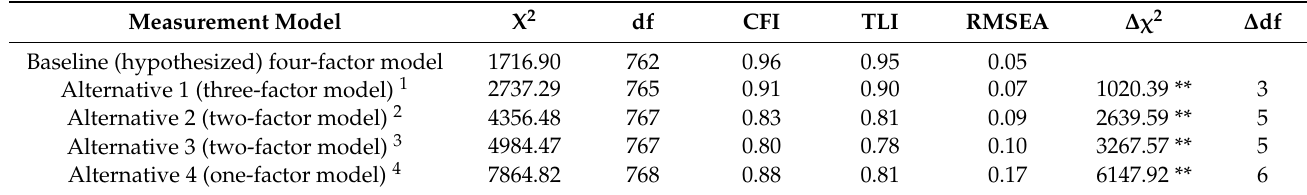
Table 2. Model Fit Statistics for Measurement